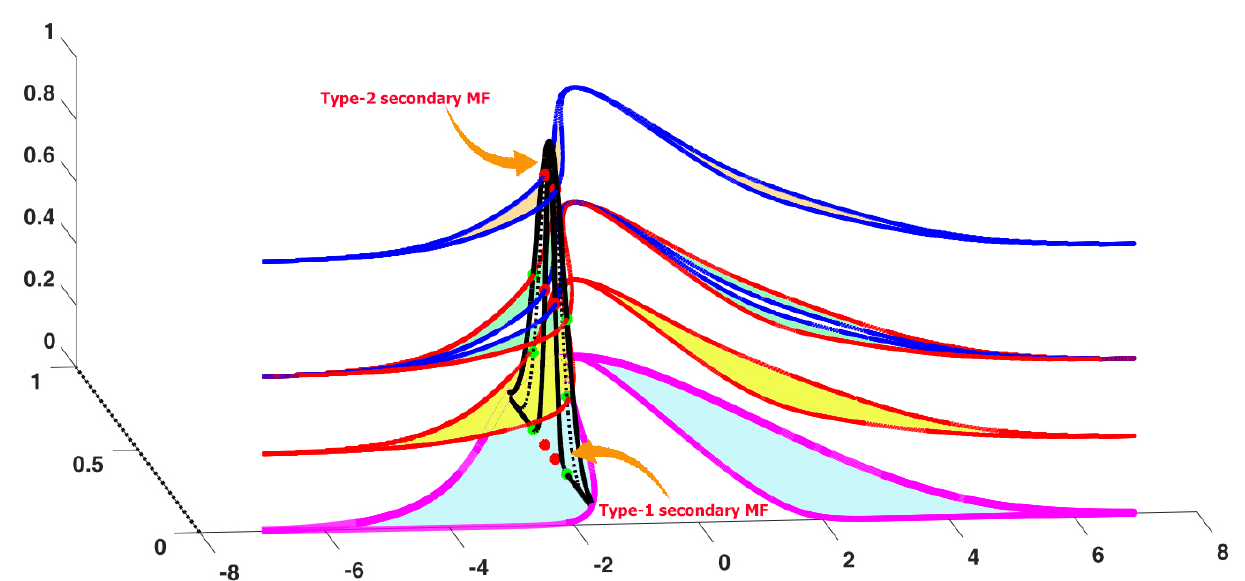
Figure 3. Horizontal slice for a type-3